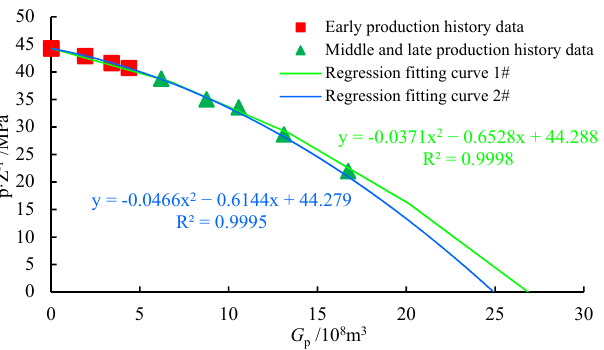
Figure 4. Pressure decline diagram of the methods of Bourgoyne (1990). The pseudo reserves correction method was utilized for the calculation, and the vir- tual dynamic reserves were calculated as G pes = 55.007 × 10 8 m 3 according to the fi tt ing of Equation (11) (Figure 5), and the fi nal real dynamic reserves were G real-a = 25.766 × 10 8 m 3 after correction according to Equation (16). We used abnormally high-pressured reser- voirs for the whole period production data to verify the accuracy of Equation (16) and the real dynamic reserves were G real-b = 25.473×10 8 m 3 . Then, we found that the method used linear extrapolation, it was less likely to cause error accumulation, and it was suitable for the calculation of early dynamic reserves.